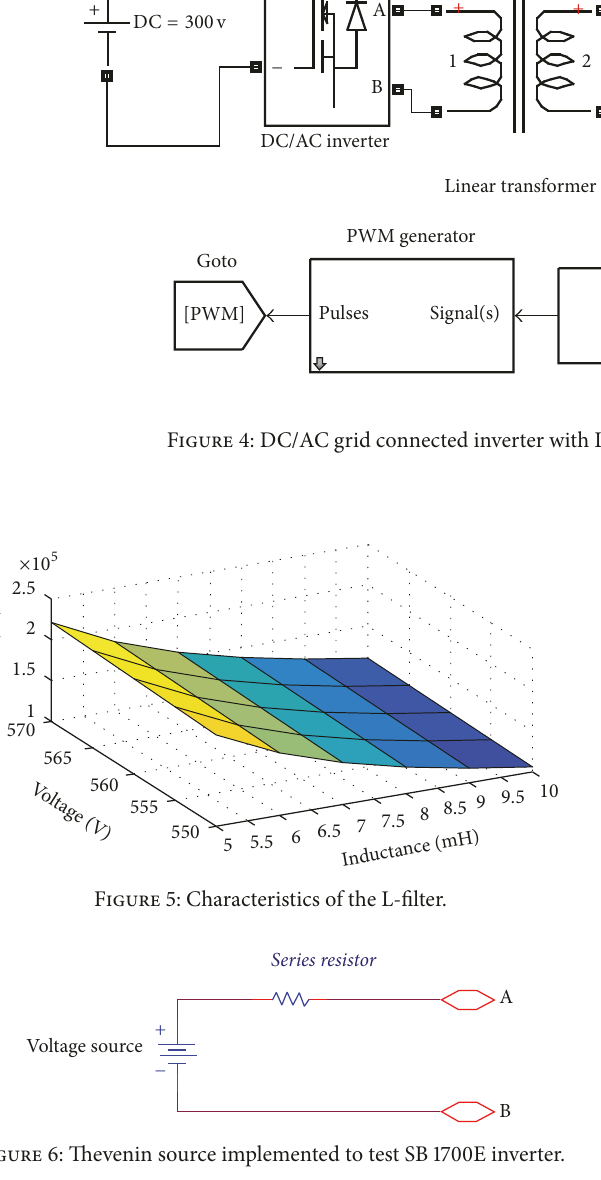
waveforms. The DC source voltage was set to 300 V and the inductor was varied and